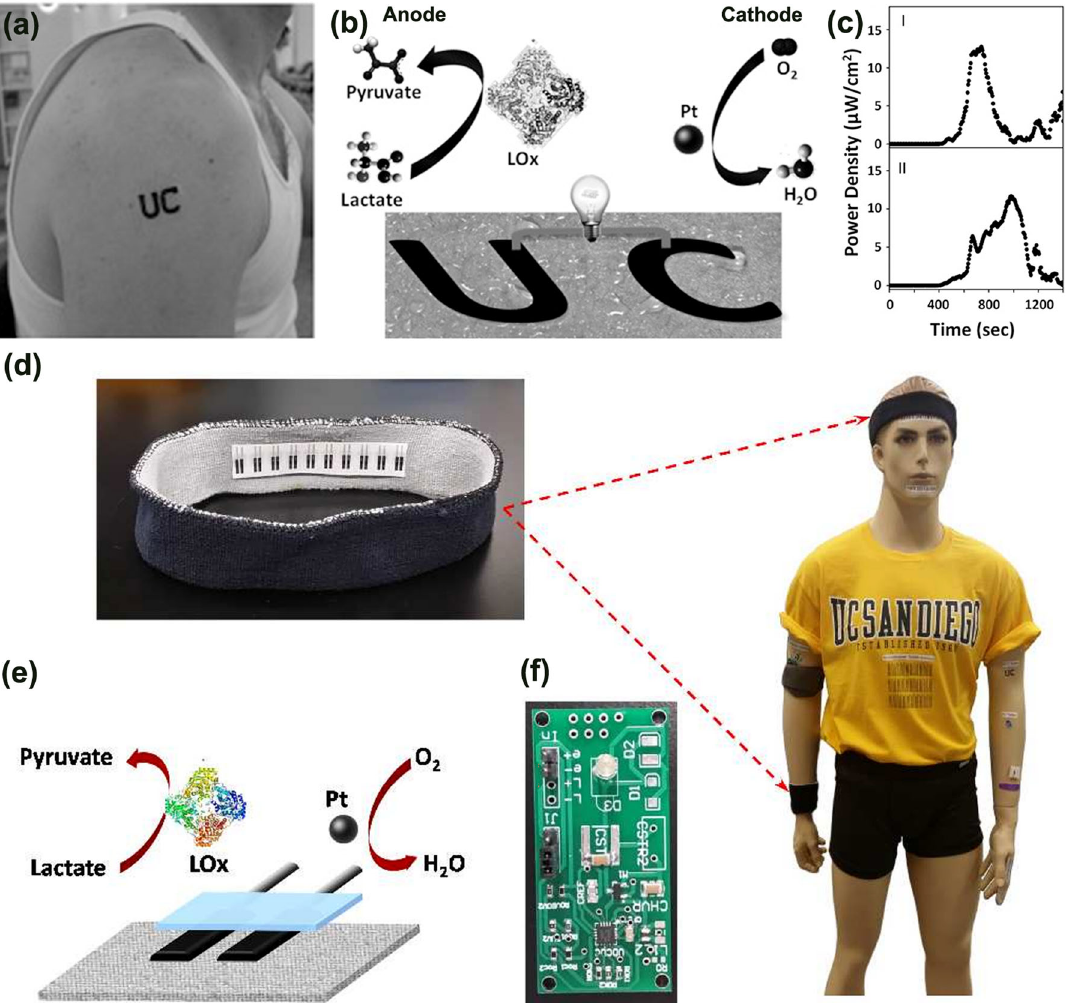
Fig. 6 Chemical energy generators. a Photograph of a UC-inspired tBFC integrated on the deltoid of a volunteer. b Schematic illustration of epidermal tBFC. c Real-time power density pro fi les obtained during (I) low, and (II) high intensity fi tness levels. Reprinted with permission from Jia et al. 151 Copyright © 2009, Elsevier. d Photograph of a wearable textile BFCs fabricated on cloth with the shape of a headbands/wristbands; inset: human like dummy wearing the tBFC-based headbands/wristbands. e 3D schema of a textile BFC including a bioanode for lactate oxidation and cathode for oxygen reduction. f A customized printed circuit board prototype for the conversion, conditioning and temporary storage of extracted energy. Reprinted with permission from Jia et al. 152 Copyright © 2014, Royal Society of